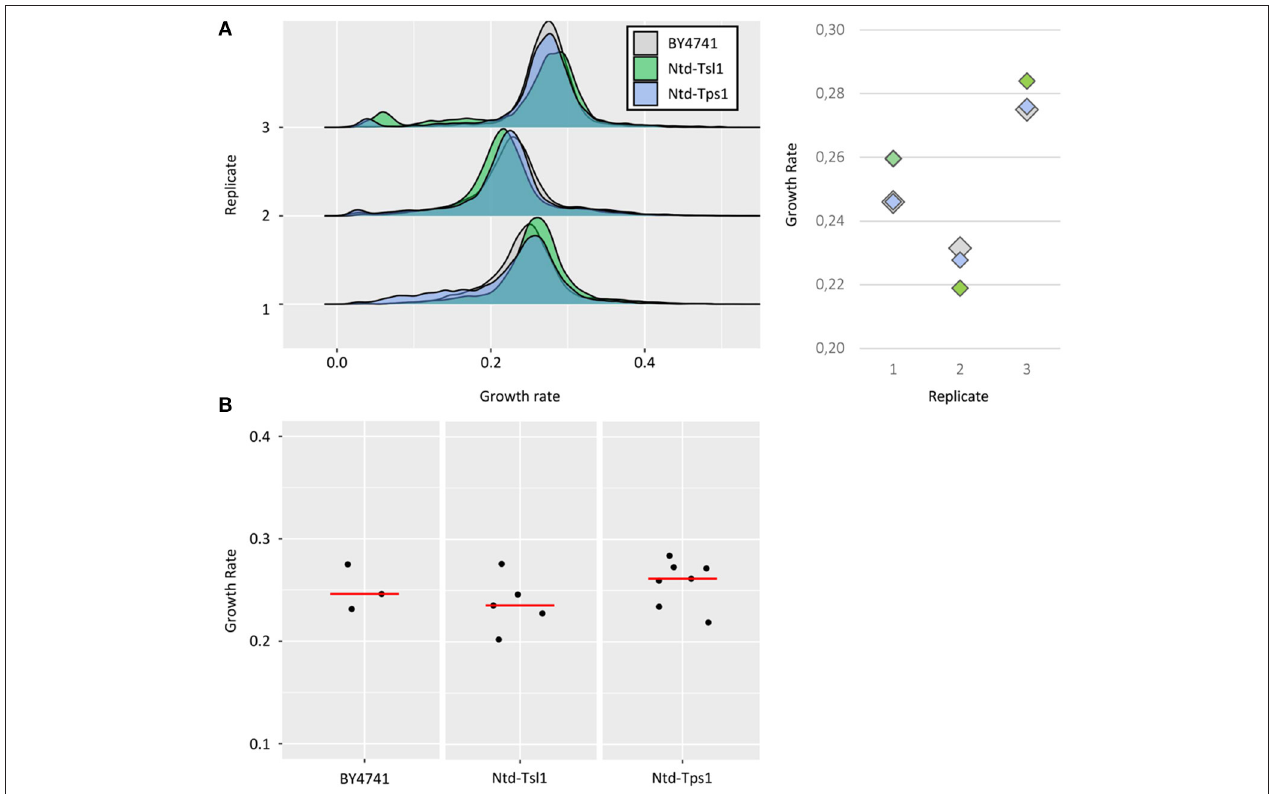
FIGURE 2 | Growth rates of BY4741 and tdTomato tagged strains. (A) Growth rate distributions of untagged BY4741 cells (gray), Ntd-Tsl1 cells (green) and Ntd-Tps1 cells (blue) from three replicates. As described in Figure 1C , growth rates were calculated for each single event after excluding the first time interval (lag phase). Median growth rates of the populations ranged from 0,22 to 0,28 h − 1 , with an average SD from the different replicates of ∼ 0,005 h − 1 (replicate #1 ∼ 0,006 h − 1 , replicate #2 ∼ 0,005 h − 1 and replicate #3 ∼ 0,004 h − 1 ). (B) Results from the three independent replicates for the BY4741 strain, the 5 independent replicates for the Ntd-Tsl1 strain and the seven independent replicates for the Ntd-Tps1 strain used to study whether increasing the number of replicates may help reducing the standard deviation and estimating better the growth rate of a strain of interest.